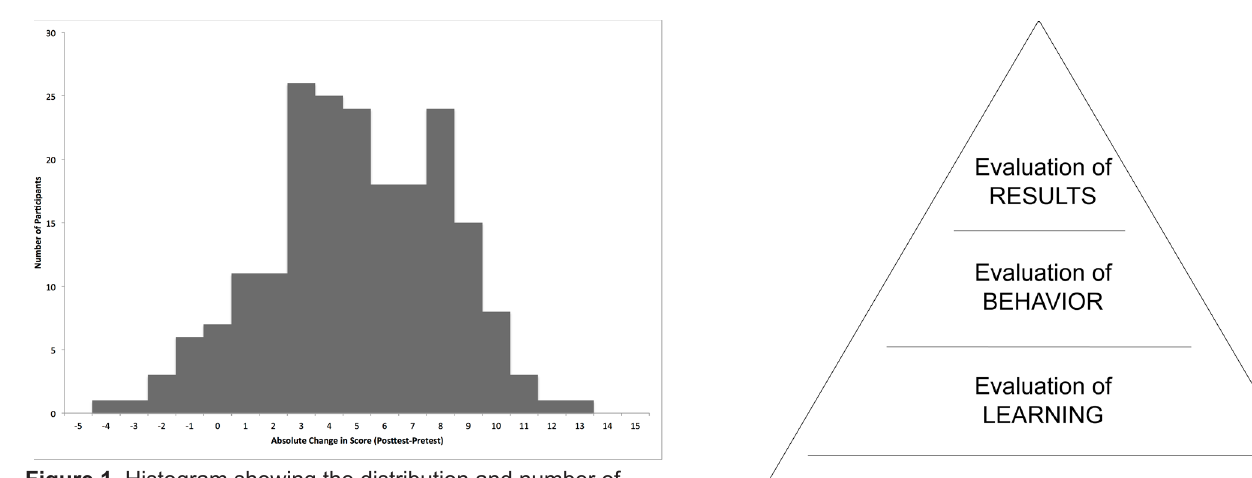
Figure 1. Histogram showing the distribution and number of participants as a function of absolute change in test scores (posttest minus pretest)